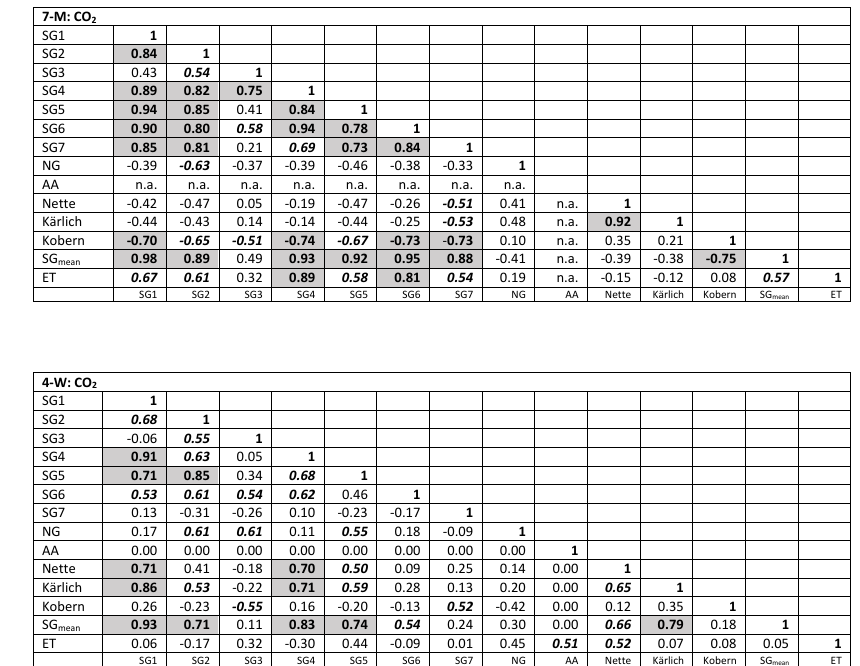
shaded. Correlations 0.5–0.7 are marked in bold‐italic; n.a. = not available.